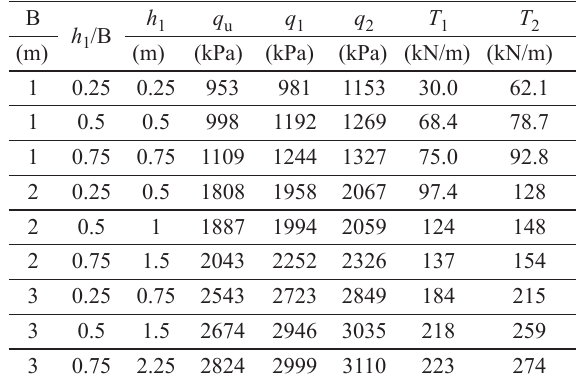
Table 4. Bearing capacity and maximum tensile forces of reinforcements obtained from FEM ( ϕ = 39° on ϕ = 36°)